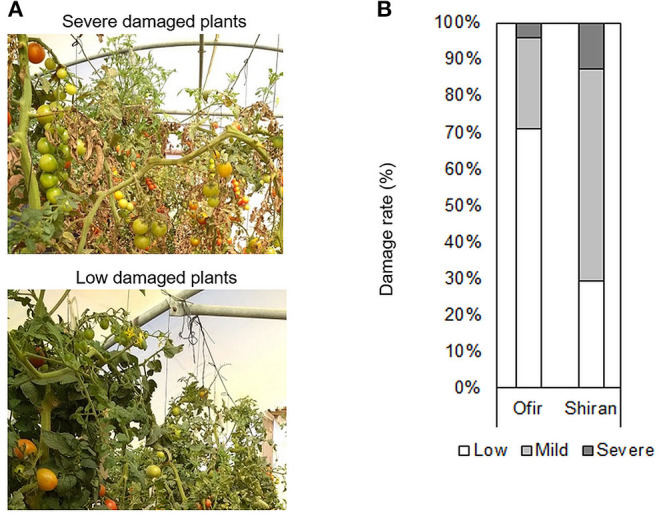
Plant damage rate of the tomato cultivars grown in a net house. (A) Photos from the tomato plants. (B) Plant damage rate of whole tomato plants. Plant severity symptoms were scored on three damage levels: (1) slight, (2) mild, and (3) severe. n = 24–26.